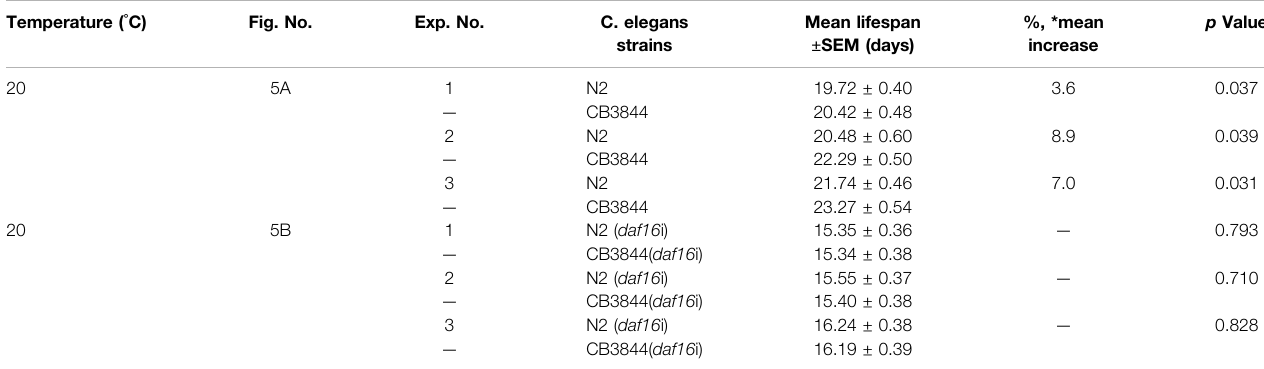
Meanlifespan:Correspondstothemeanlifespanasmeasuredinthepresentstudy.Themeanlifespanvalueswerecalculatedbythelog-rank(Kaplan – Meier)statisticaltest. p valuesless than 0.05 wereconsideredstatistically signi fi cant, whereas statisticalsigni fi cancewas not calculated (-) when p values were > 0.05.All statisticalevaluations werecalculated using SPSS 25. Each experiment included 100 C. elegans nematodes. SEM: standard error of the mean.